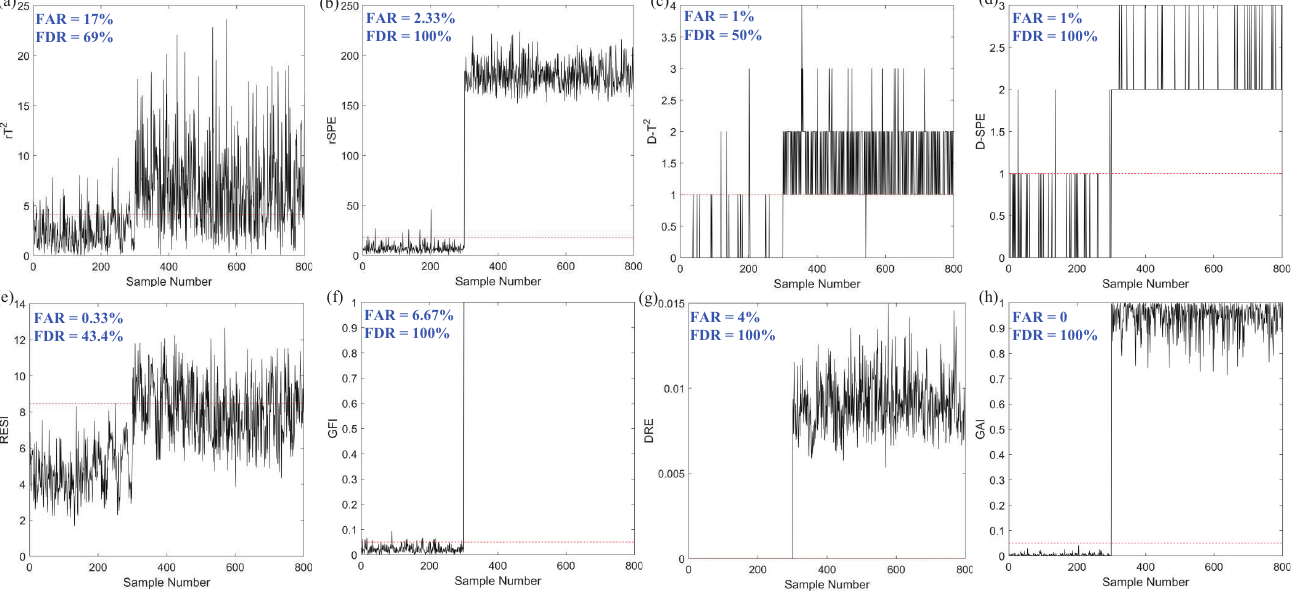
Figure 5. The process monitoring results of numerical simulation experiment. ( a ) rPCA- rT 2 ; ( b ) rPCA- rSPE ; ( c ) DPCA- D − T 2 ; ( d ) DPCA- D − SPE ; ( e ) KSVD- RESI ; ( f ) DDL- GFI ; ( g ) DPL- DRE ; ( h ) DRDPL- GAI . Table 1. The comparison results of numerical simulation